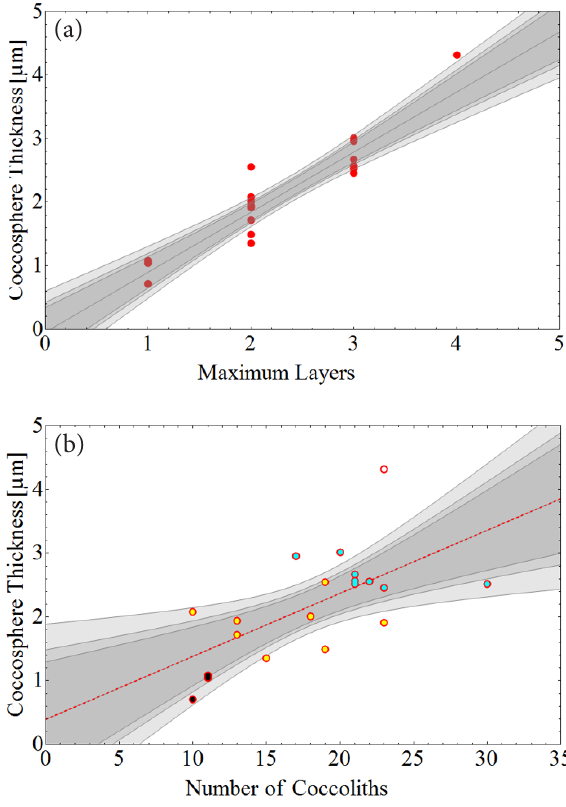
Figure 4. (a) The relationship between the number of coccolith lay- ers which make up the sphere and the thickness of the coccosphere shell is given. A maximum four layers was found in this strain. It can be observed that the thickness increases by approximately 1µm with each coccolith layer. (b) In this plot the thickness is plotted as a function of the number of coccoliths. The black dots refer to coc- cospheres with a maximum of one layer, the yellow to those with a maximum of two layers, the blue to those with a maximum of three layers and the white to those with a maximum of four layers. The fitted slopes as well as the calculated 0.9, 0.95 and 0.99 confidence levels are given by the grey